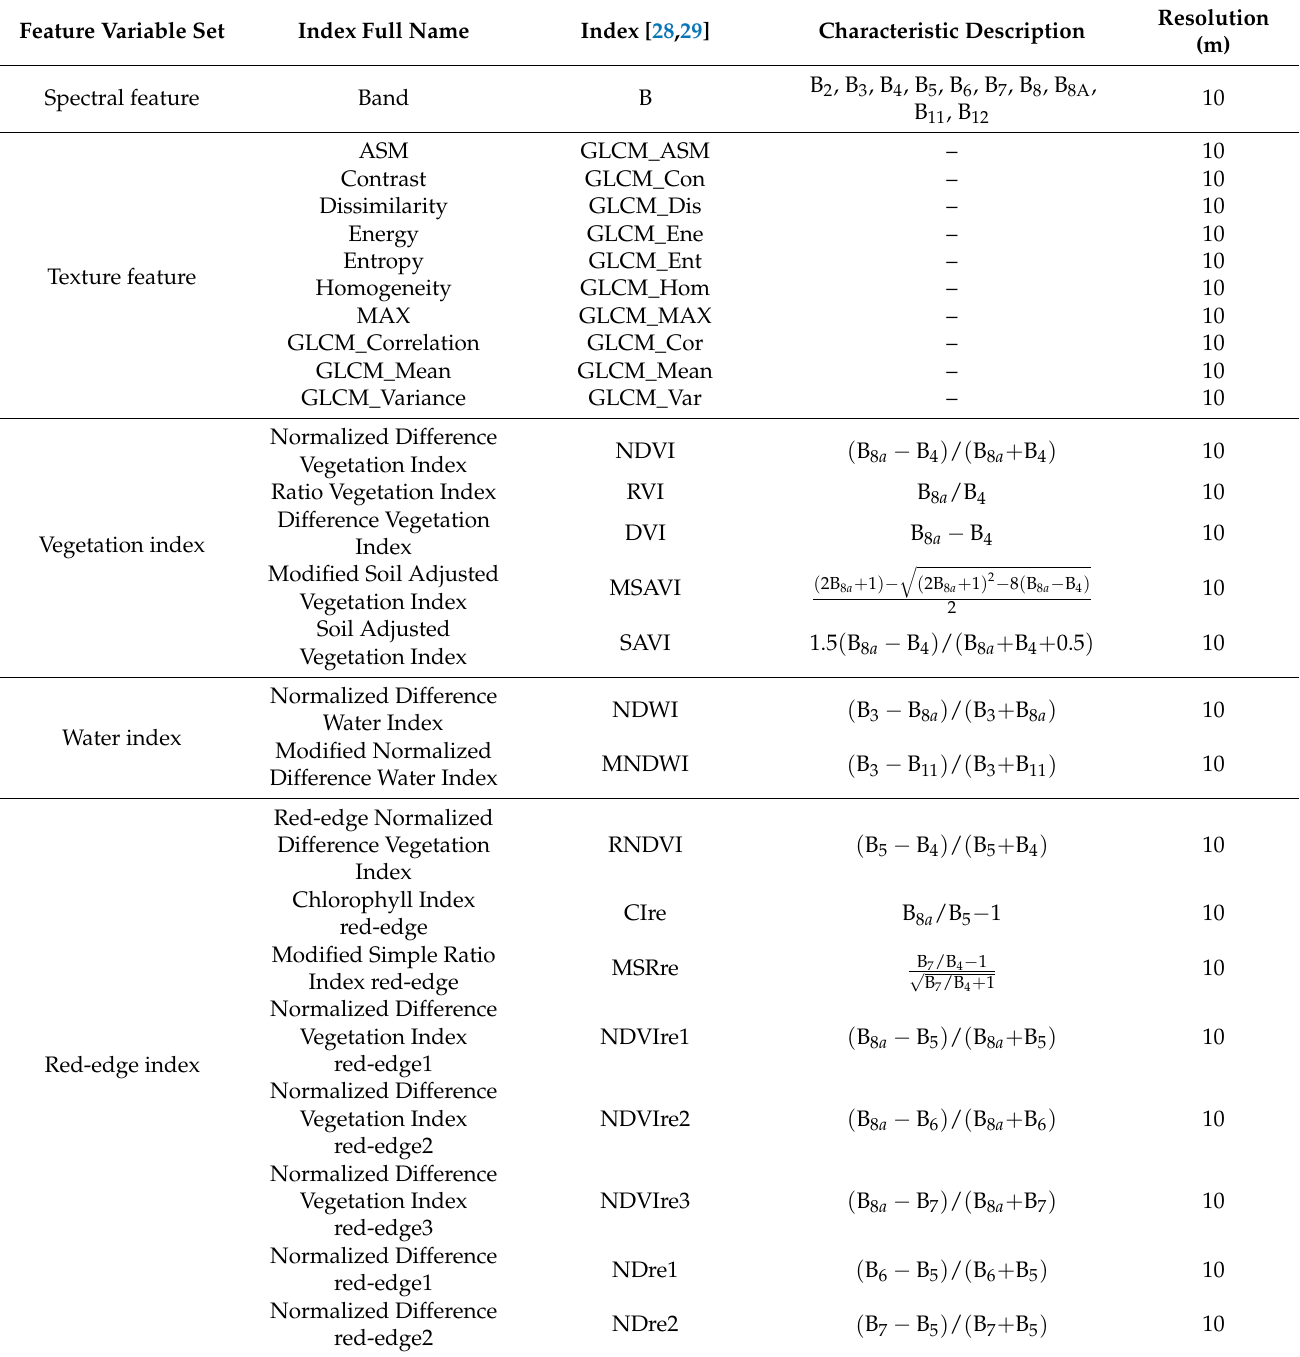
Table 2. Descriptions of the feature variables derived from Sentinel-2